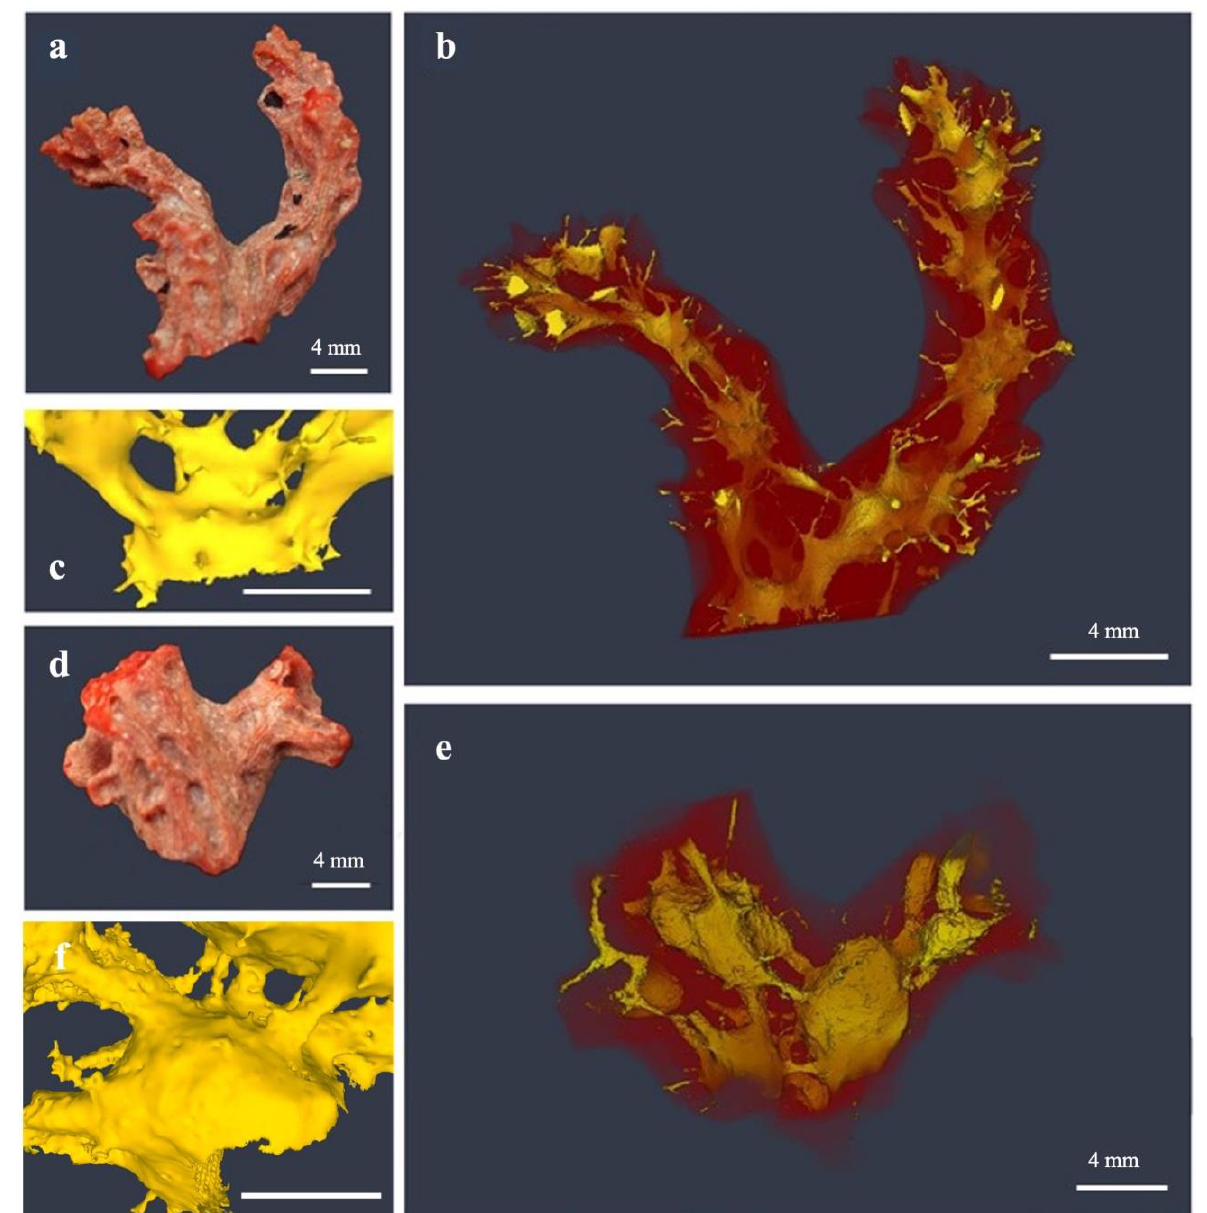
Figure 6. Three-dimensional visualisation of the two red coral samples excavated by Thoosa armata from micro-CT reconstructions: ( a , d ) red coral samples CT6 and CT5, respectively; ( b , e ) eroded cavities represented in yellow and coral in transparent red; ( c , f ) details of T. armata erosive pattern. Scale bars in ( c , f ) equal to 2 mm.